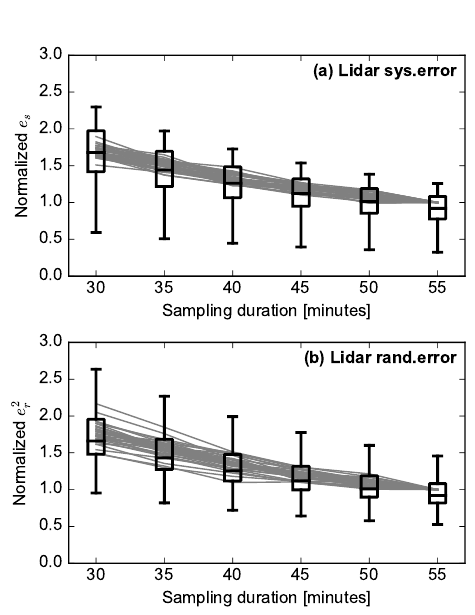
Figure 11. Relationships between (a) the systematic error ( e s ) and the sampling duration and (b) the random error pling duration for radial velocity variance estimated from the lidar data using the autocorrelation method (gray lines) and the station- r , b ary bootstrap method (box plots). All errors are normalized by the errors estimated from the autocorrelation method with a sampling duration of